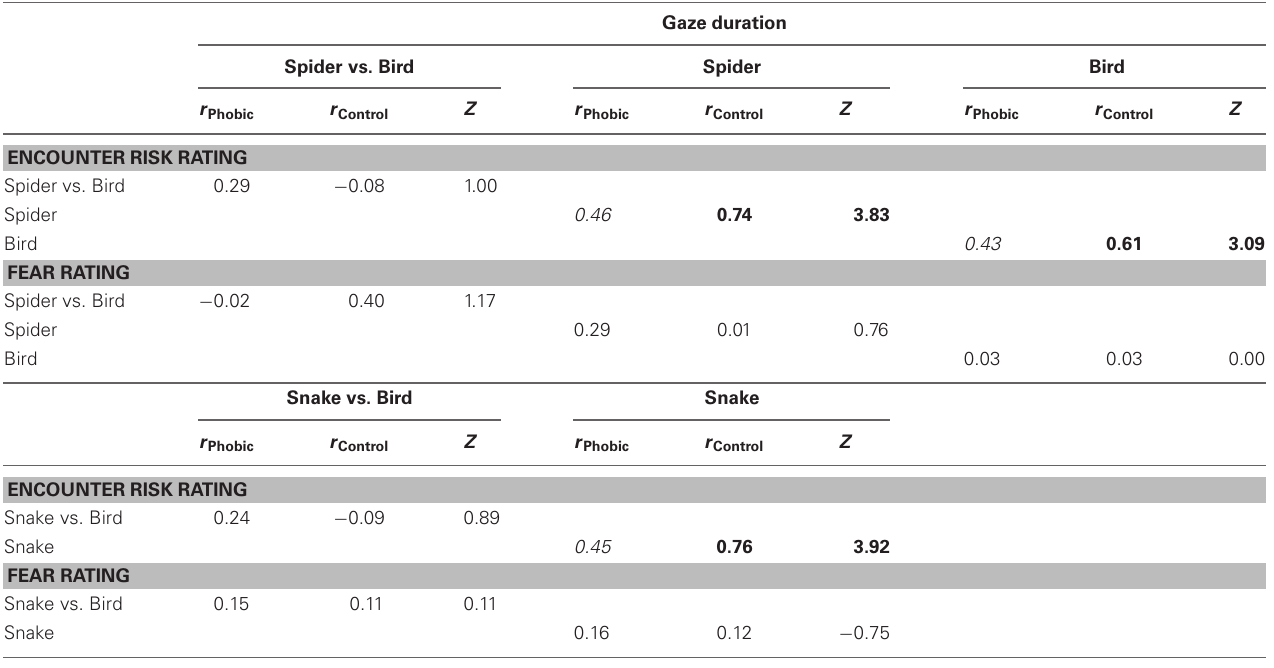
Table 4 | Correlations between gaze duration and participants’ encounter risk and fear